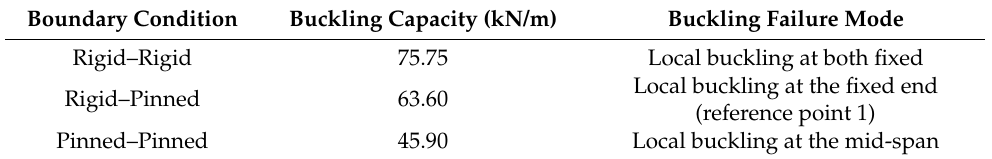
Table 17. Buckling capacity and corresponding buckling modes under different boundary